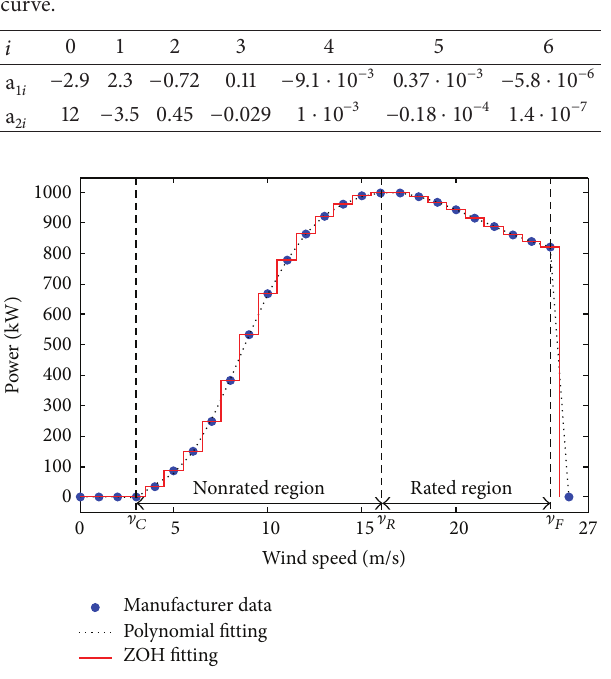
Figure 3: Power curve of NEG Micon 1000/60 fixed speed wind